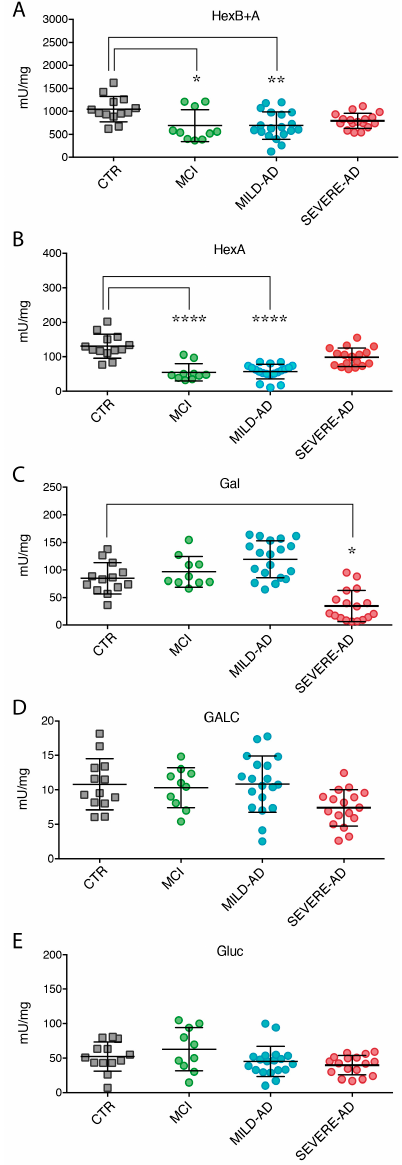
Figure 2. Lysosomal hydrolases activity ( A – E ) in PBMCs of mild AD, severe AD, MCI, and control subjects. Levels of hydrolases were measured by using specific fluorogenic substrates (see Section 4 for details). Results were expressed as the mean ± SEM of five independent experiments, each in triplicates. * p < 0.05, ** p < 0.01, **** p <